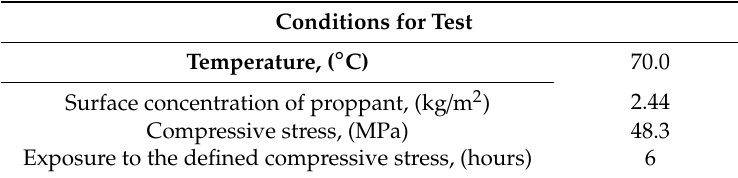
Table 1. Conditions for the tests no. 1 and no. 2.